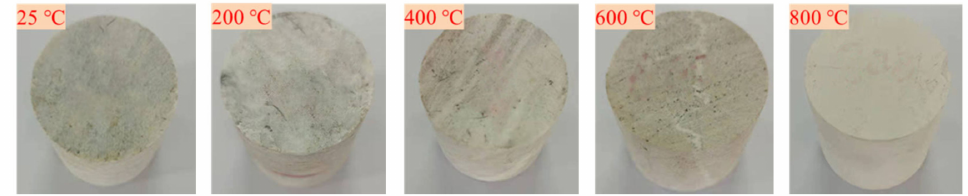
Figure 5. Apparent morphology of marble specimens after high-temperature